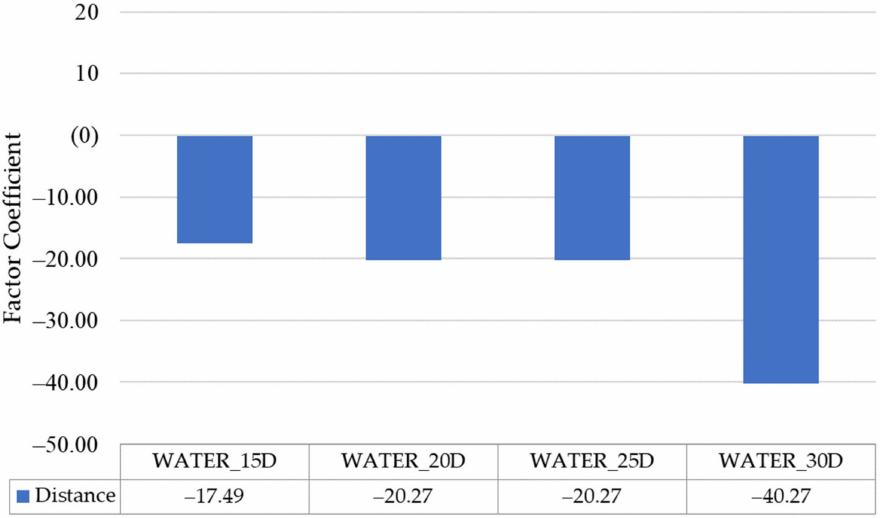
Figure 6. Coefficients of the significant factors for statistically reliable models associated to Water. The associated error is equal to 0.05%.